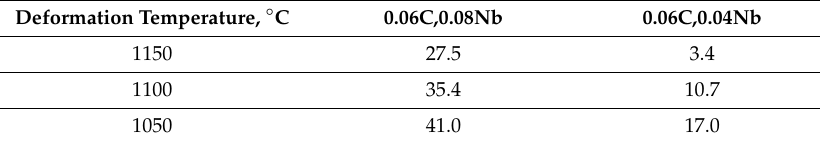
Table 1. NbC pinning force at the respective deformation temperature,